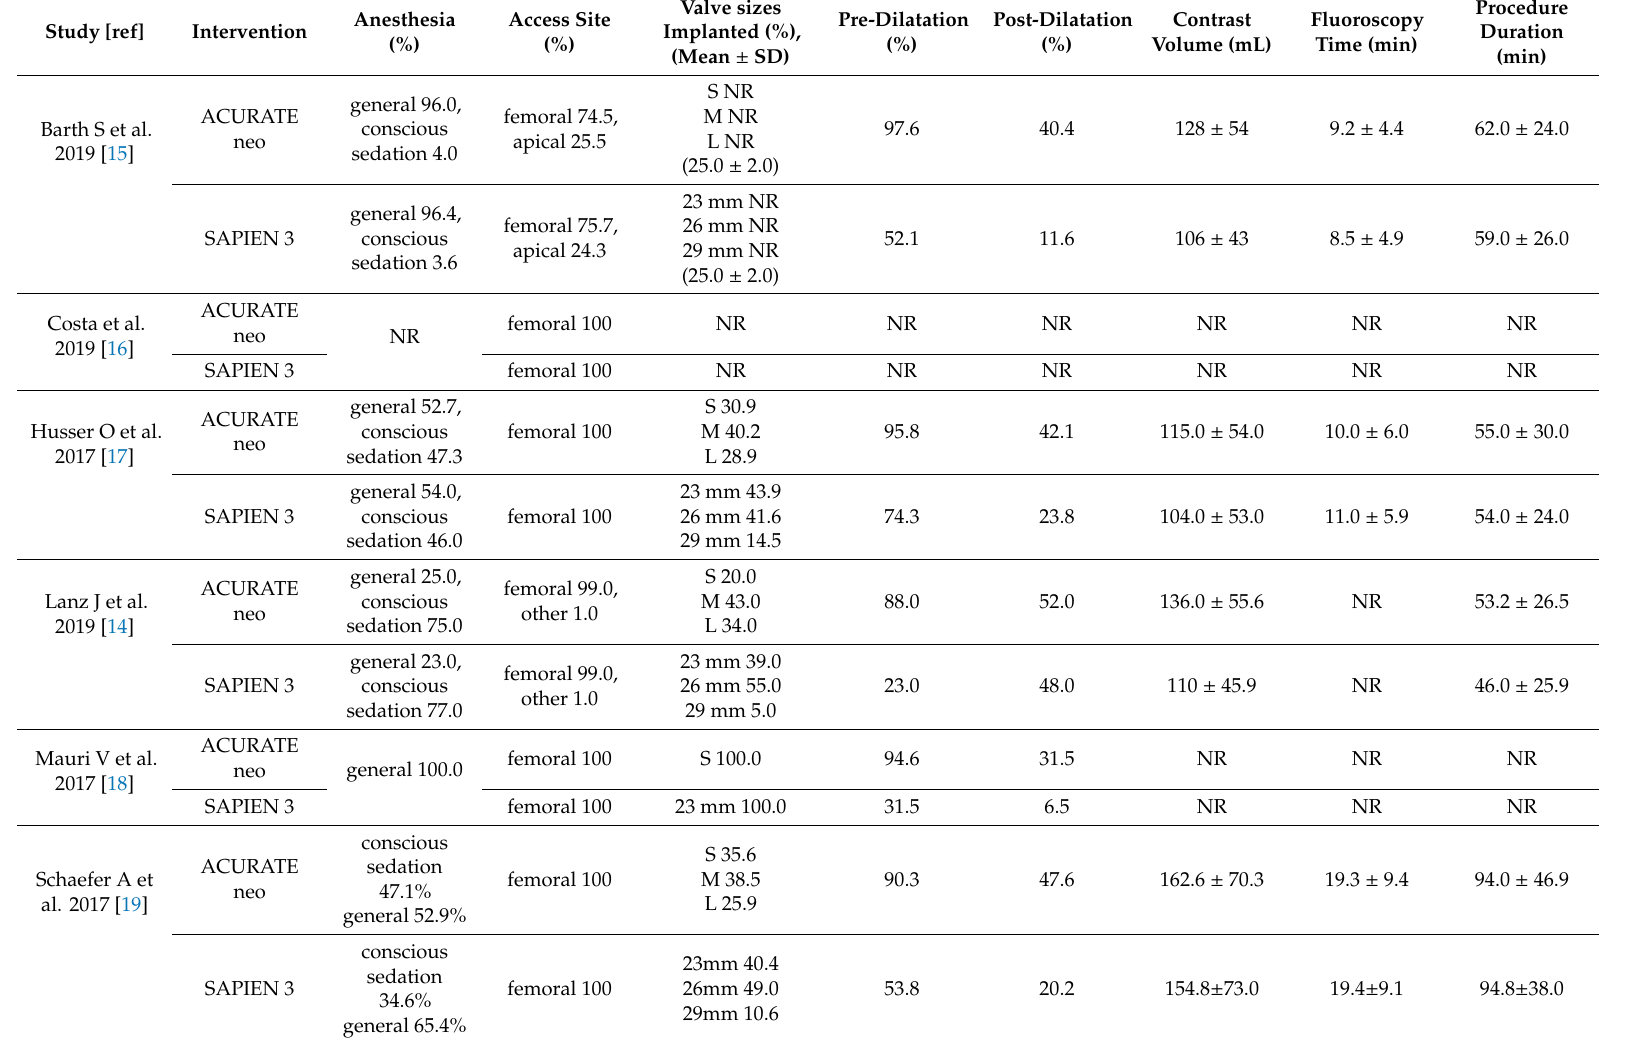
Table A5. Procedural